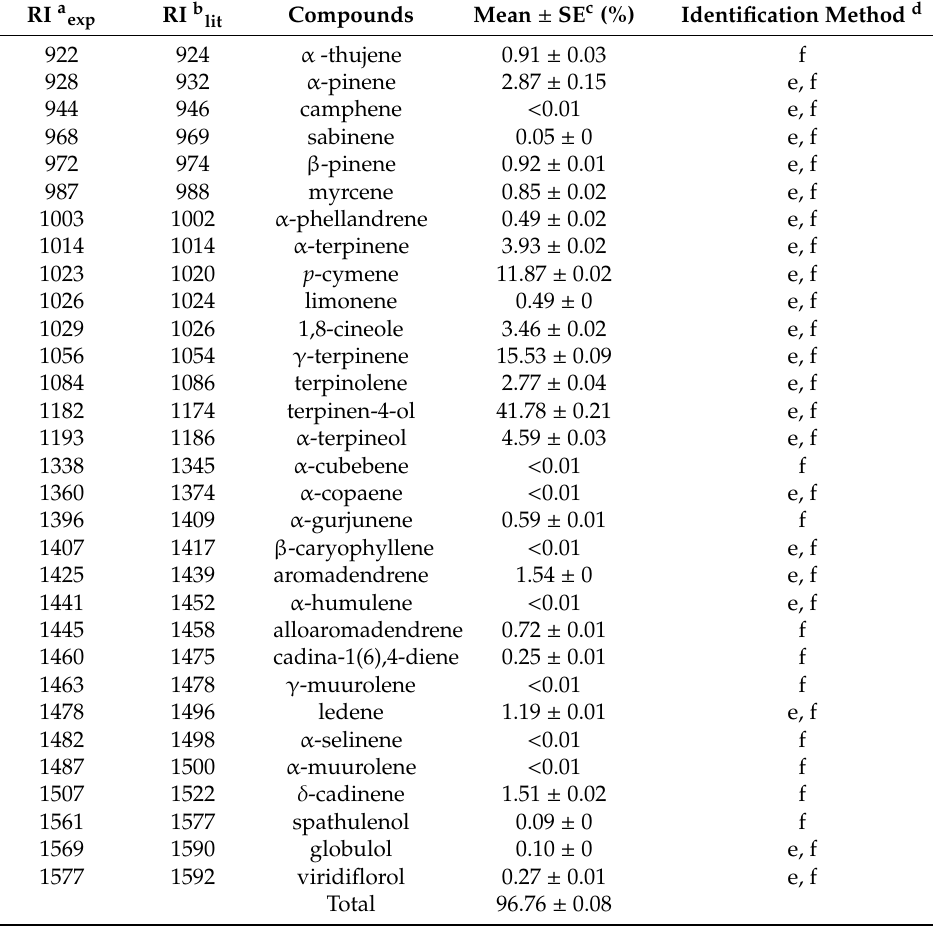
Table 4. Chemical composition of tea tree essential oil